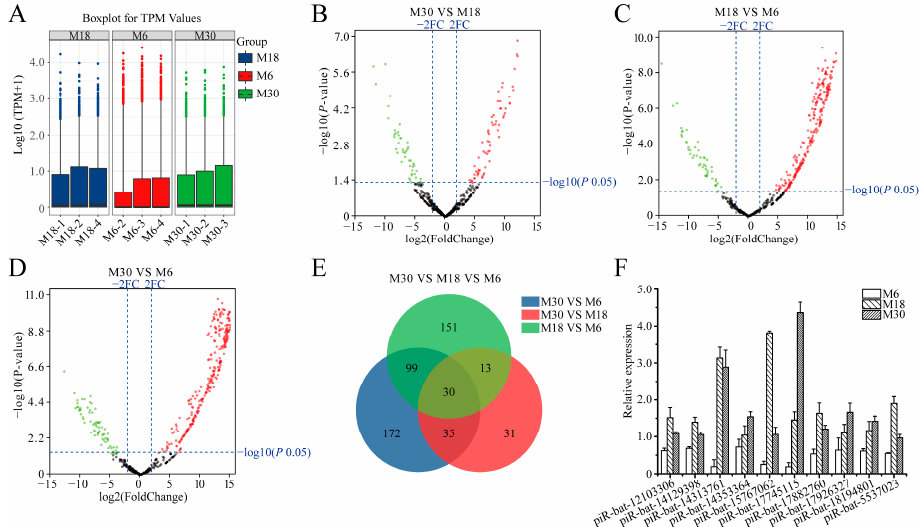
Figure 2. Comparative analysis of piRNAs in yak testis at different developmental stages. ( A ) The expression level of miRNAs in 6-, 18- and 30-month-old yak testes; ( B ) differences of piRNA expression between M30 and M18 libraries; ( C ) differences of piRNA expression between M18 and M6 libraries; ( D ) differences of piRNA expression between M30 and M6 libraries; ( E ) common differentially expressed piRNAs of M30, M18 and M6 libraries; ( F ) validation of piRNAs expression levels with real-time PCR; red, green, and grayness dots in the graph represent transcripts that were significantly upregulated, downregulated, and unchanged, respectively.